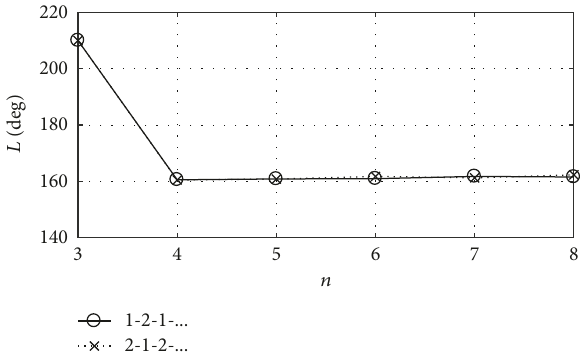
Figure 2: Path lengths according to the number of maneuvers for case 1.